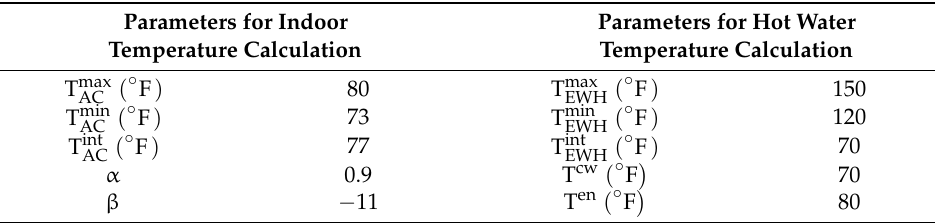
Figure 6. Real ‐ time pricing of the utility. Figure 6. Real-time pricing of the utility. Table 2. Parameters of thermal comfort of the user. Table 2. Parameters of thermal comfort of the user.